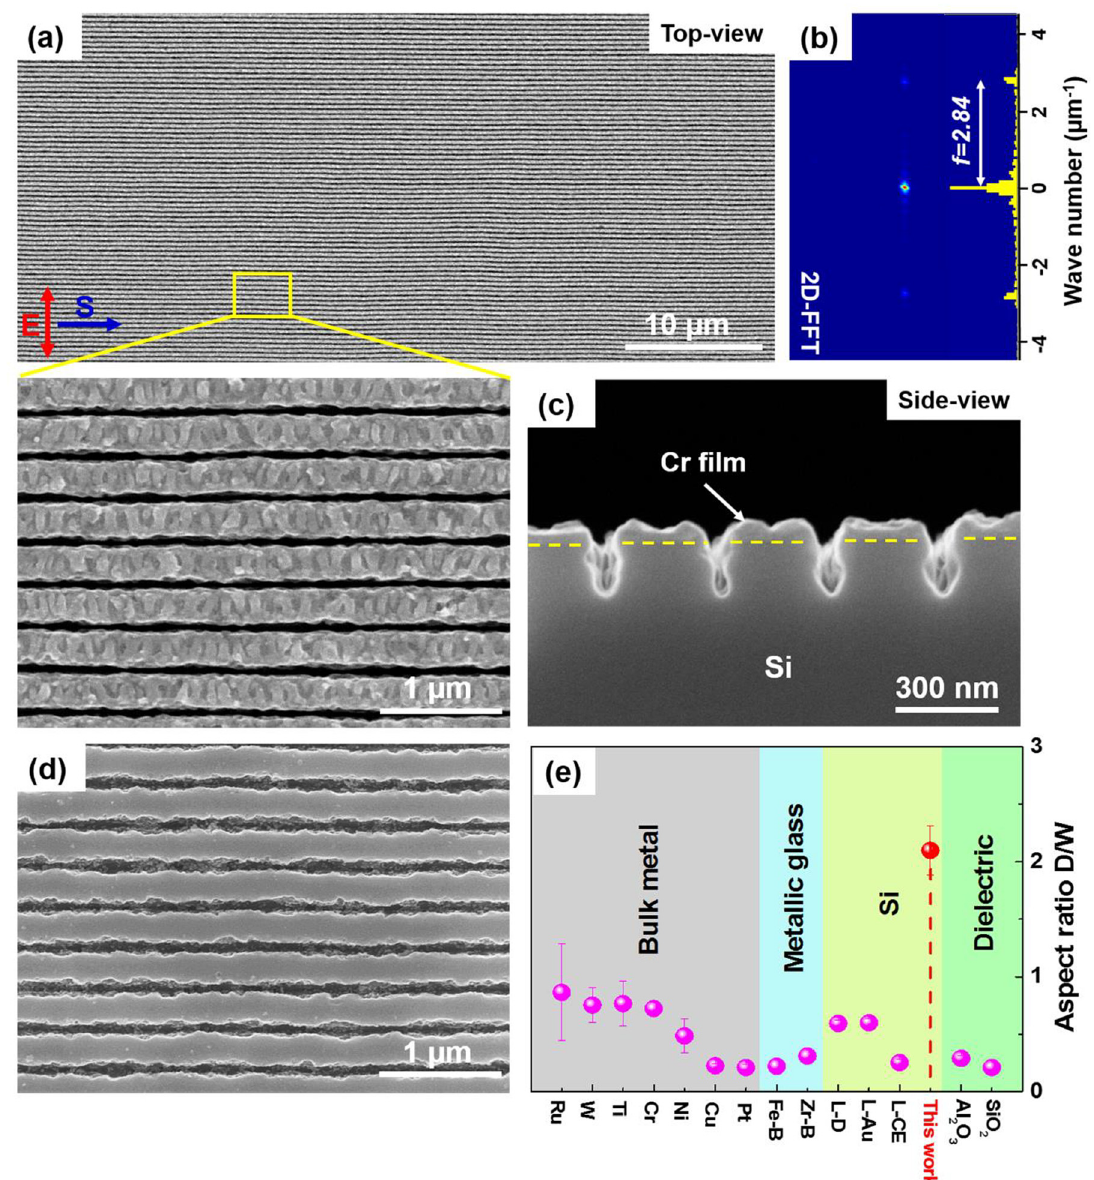
Figure 2: (a) SEM images (top view) of the laser-induced ablative nanograting structures on the surface of 25 nm thick Cr/Si sample. E and S representthedirectionofthelightpolarizationandsamplescanning.(b)Calculated2D-FFTimageoftheablatedgratingstructures,indicating a highly regular arrangement of the groove structures with a spatial period of 352 nm. (c) SEM image (side view) of the laser-induced nanogratingstructures,exhibiting an anomalouslynarrow-necked cross-sectional pro fi le and a penetrating ablation into the Si substrate. (d) SEM image of the laser-induced nanograting structures on the Si substrate after removing 25 nm thick Cr layer by a Cr etchant solution. (e) Illustration of the depth-to-width aspect ratios for reported laser-induced nanograting structures and the Si nanograting structures in our work.Here,Fe-BandZr-BrepresentFe-basedandZr-basedmetallicglass,respectively;L-DforLIPSSsontheSimaterialdirectlyprocessedby femtosecondlaserpulses;L-AuforLIPSSsontheSimaterialcoatedwithAu fi lms;L-CEforLIPSSsontheSimaterialprocessedbythechemical etching assisted femtosecond laser modi fi